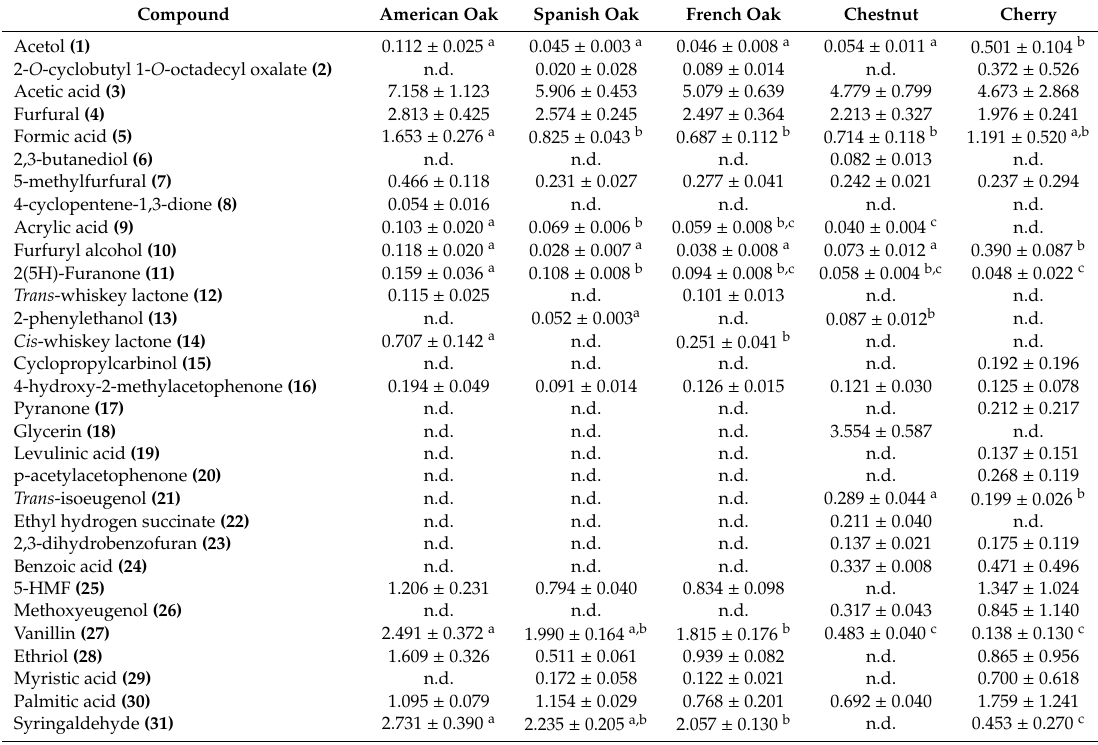
Table 7. Relative area values of volatile compounds determined by DTD-GC-MS of wood